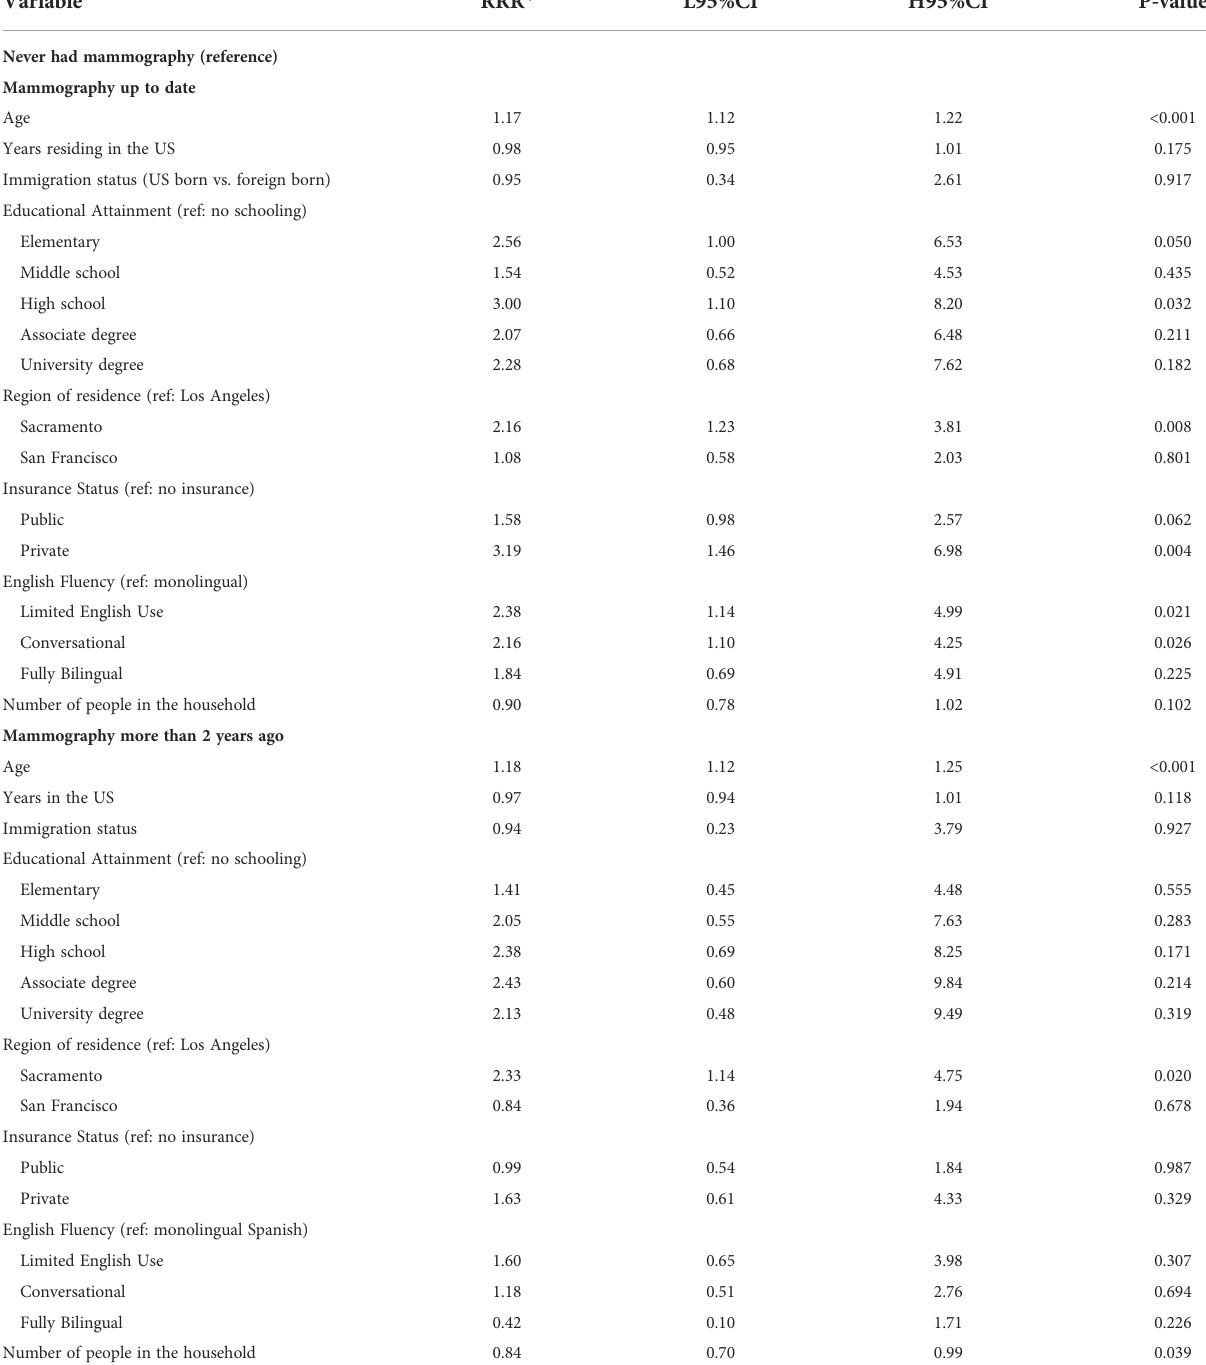
TABLE 4 Multivariate multinomial logistic regression model testing the association between breast cancer screening behavior and demographic factors among ‘ Tu Historia Cuenta ’ participants ages 40 to 74 (N=587, 42 excluded from 629 due to missing data). Variable RRR* L95%CI H95%CI